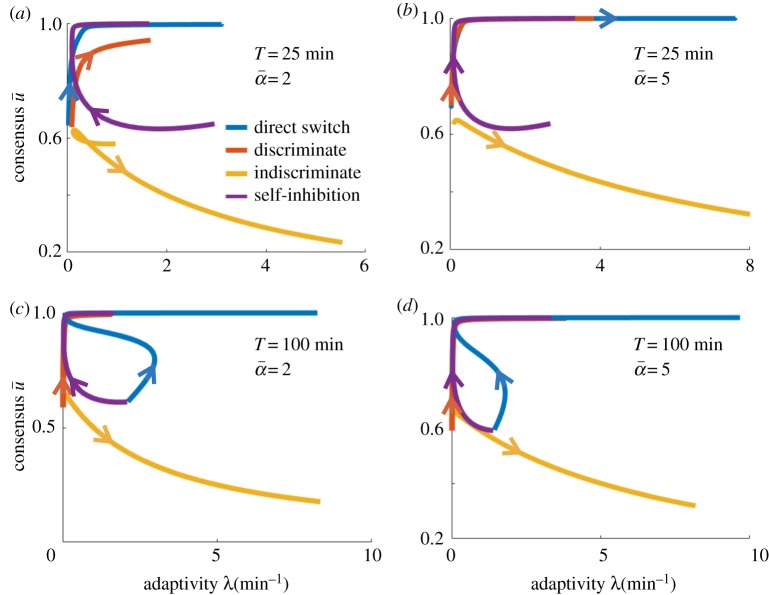
Consensus u¯ and adaptivity λ computed as described in §§B(b) and B(d), as social inhibition strength ρ is increased between [0,20] min−1 (along the direction of the arrows) for all models. Other parameters are fixed at their optimal level.